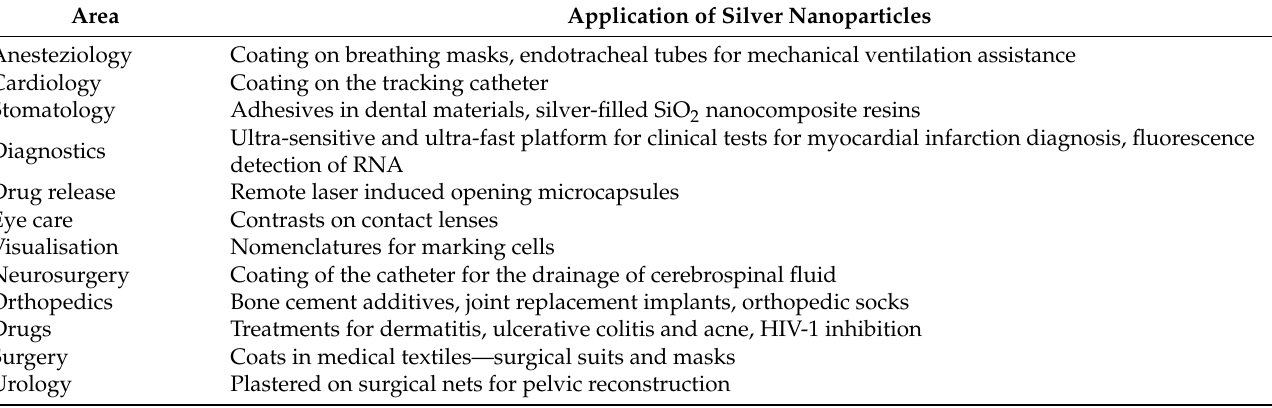
Table 4. Application of silver nanoparticles in medicine items